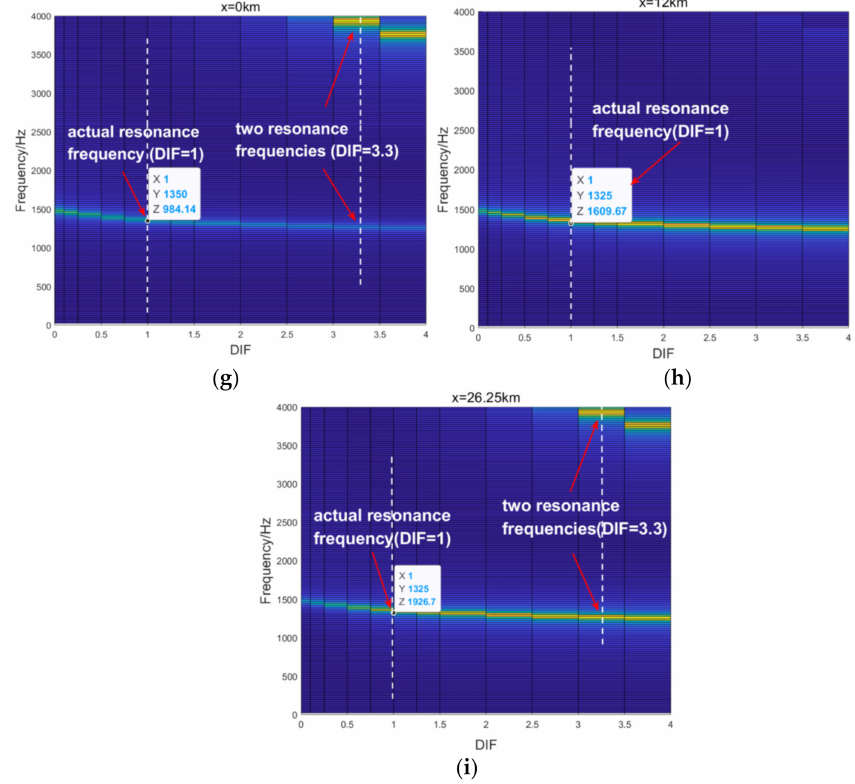
= z ∗ = z ∗ = 1; ( b ) z ∗ = 0.001; 00 55 00 55